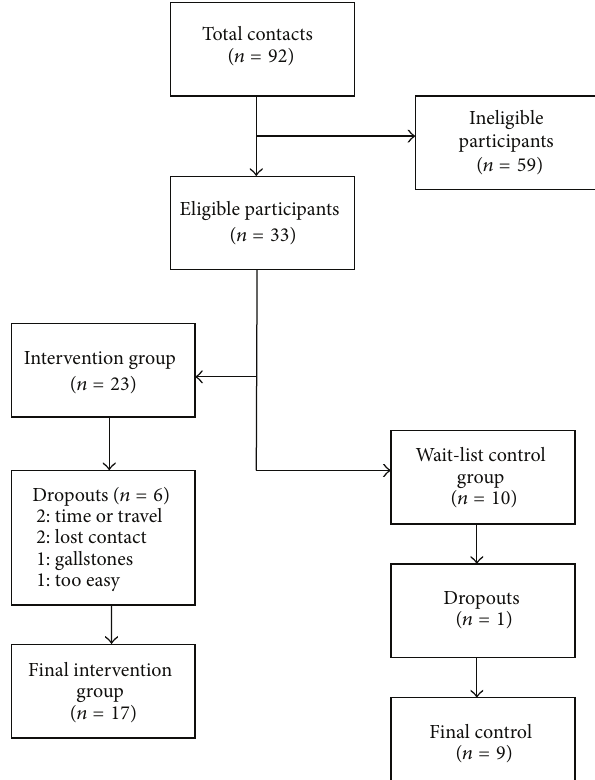
Figure 1: Flow chart of participants throughout the study. The total analytical sample consisted of 26 participants, with 17 in the EXD group and 9 in the control group.